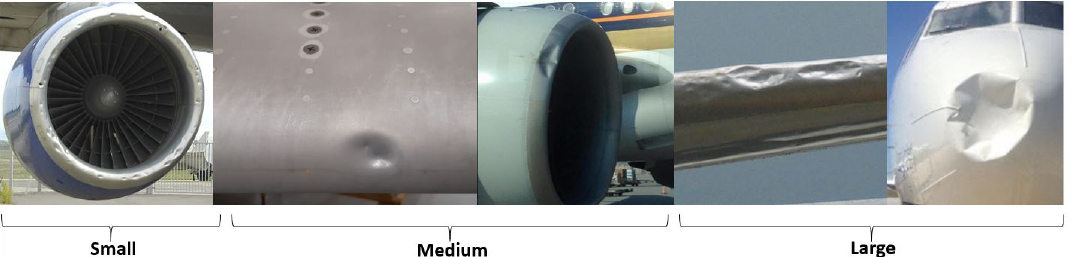
Figure 6. Various dent sizes used in model training.